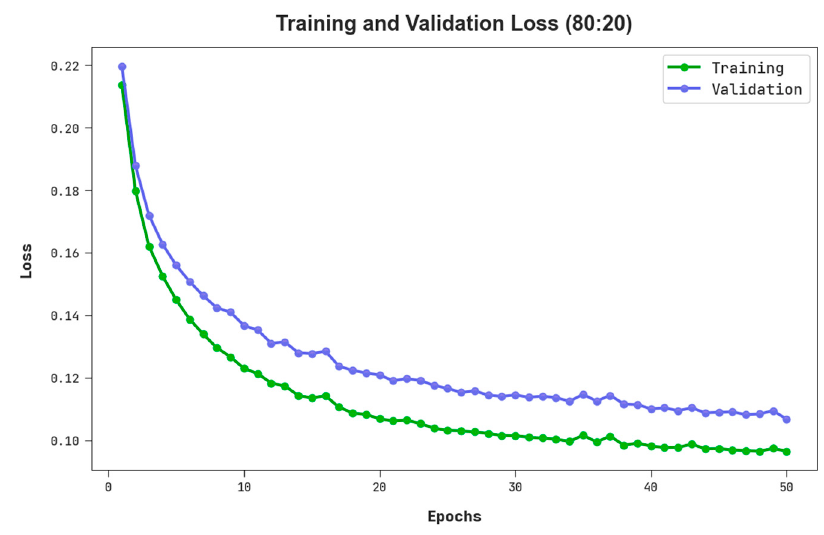
Figure 6. TLS and VLS outcome of RHSODL-AMD system on 80:20 of TRS/TSS.